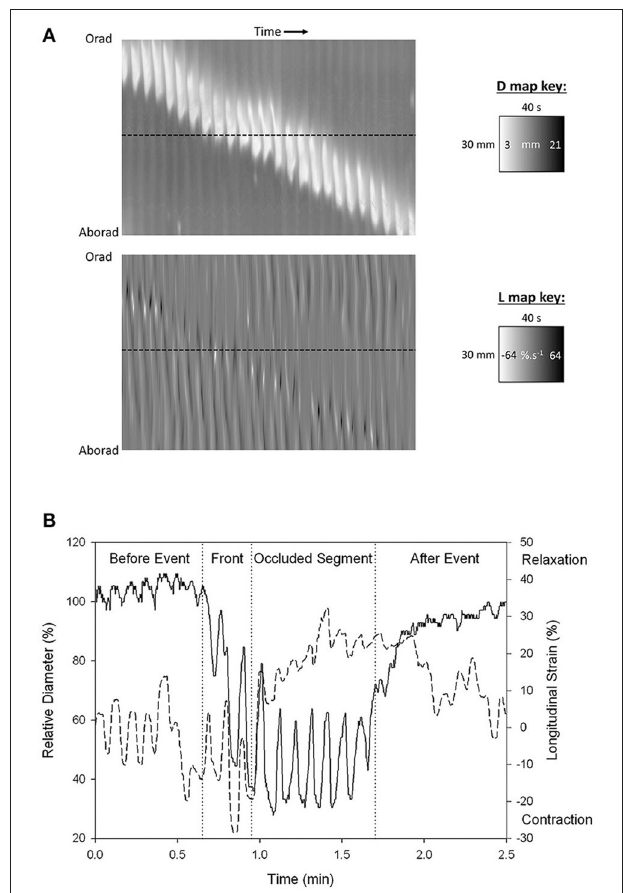
FIGURE 2 | Synchronous (A) D-type (diameter type) ST map (left) and L-type (right) (linear strain rate) ST maps and graph of transects (B) showing progression of a peristaltic contraction though a segment of possum ileum. (A) Lighter areas on the D-map indicate sites along the length of the organ where the diameter is reduced and darker areas sites where the diameter is increased. The thickness of the band measured horizontally is the duration of the contraction. The thickness of the band measured vertically is the length of the organ that is undergoing contraction at any given time. The angulation of the band to the horizontal (time) axis is proportional to the velocity of propagation of the constricted area. Note the component vertical “stripes” on the D map which indicate rapid activation of successive regions of smooth muscle occurring at the slow wave frequency. Note also the darker shading i.e., distension in advance of the propagating lighter band than that in the rear showing that lumen contents are being propelled in advance of the constriction. Lighter areas on the L map indicate sites of negative longitudinal strain rate i.e., constriction in the longitudinal dimension. Events at the horizontal dotted line, placed at the same site in the two maps ( B below), indicate that longitudinal shortening occurs in advance of the circular constriction (B) Coordination between D (solid line) and L (dashed) maps during a peristaltic event . Values were taken from the horizontal line delineating a particular site on the synchronous D and L maps. Contractions are seen to be 180 ◦ out of phase prior to the peristaltic contraction and in phase during the contraction. The amplitude of circular contraction on the D map increased during the peristaltic event. Figures adapted from Lentle et al.